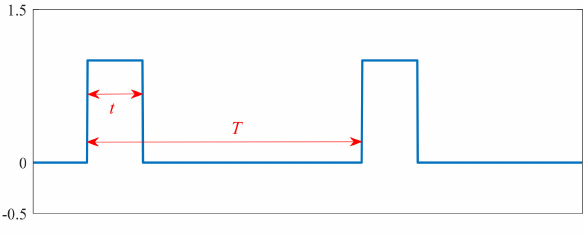
Figure 1. The flowchart of